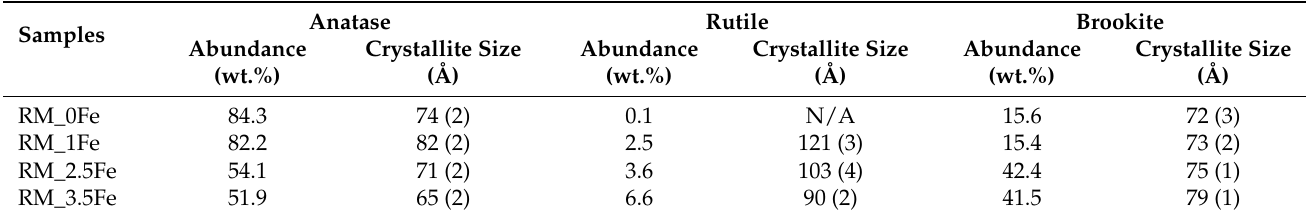
Table 1. QPA results concerning the abundance (wt.%) and the crystallite size (Å) of anatase, rutile and brookite in the samples.